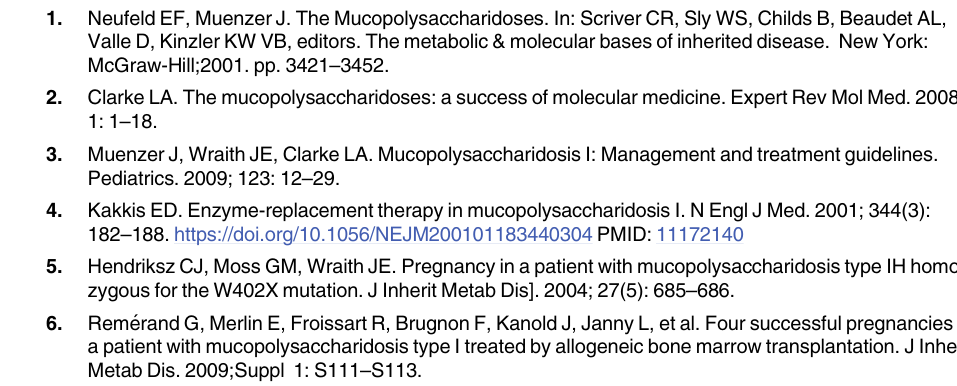
S2 Fig. Analysis of female locomotor activity. Three-month-old female Idua +/_ and Idua -/- were submitted to open field test for 5 minutes the day before sexual behaviour testing. The number of central and peripheral quadrants was counted, as well as the frequency of rearing (vertical activity) and grooming. Statistical analysis: generalized linear models. � p < 0.05 com- pared to control